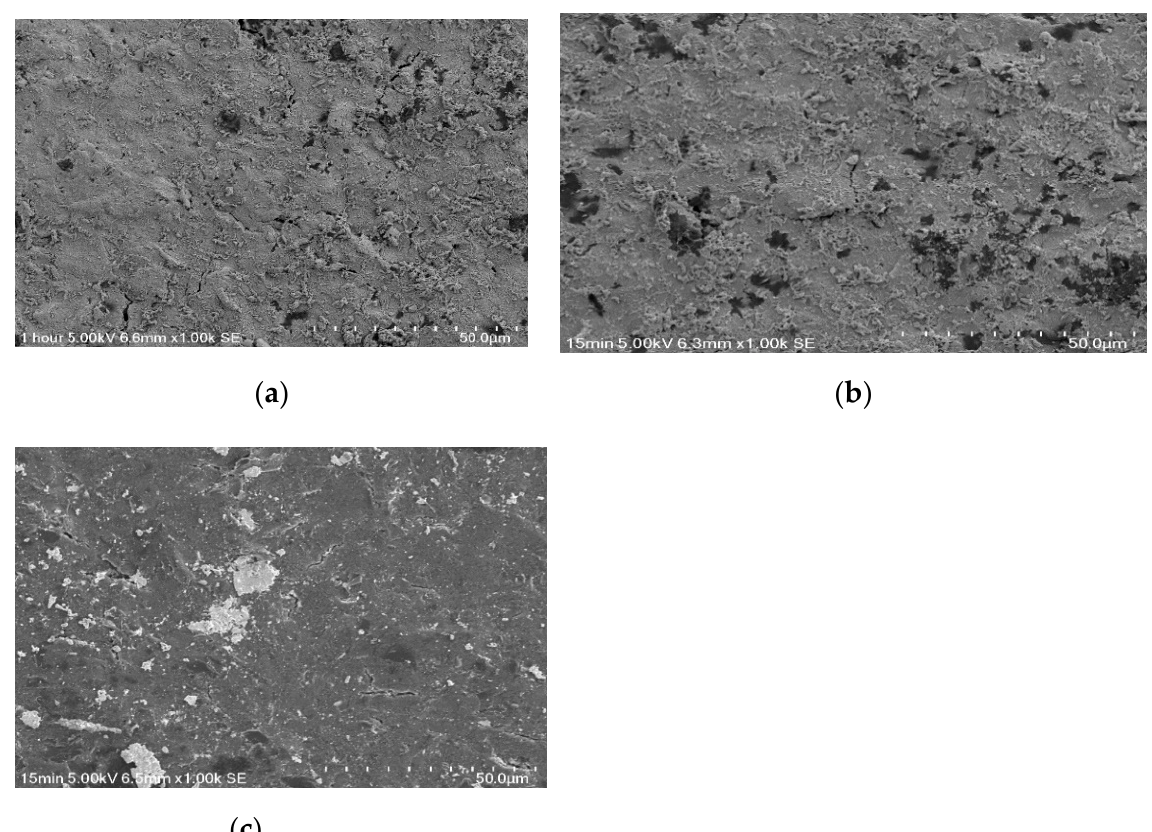
Figure 4. SEM images of TiN films deposited on the glass substrates using different process pa- rameters: ( a ) , TiN surface magnified x 1000 prepared at 9:1 (Ar:N 2 )gas ratio, ( b ) TiN surface at 10:2 (Ar:N 2 ) gas ratio and ( c ) TiN surface showing smooth morphology prepared at 10:10 (Ar:N 2 ) gas ratio.